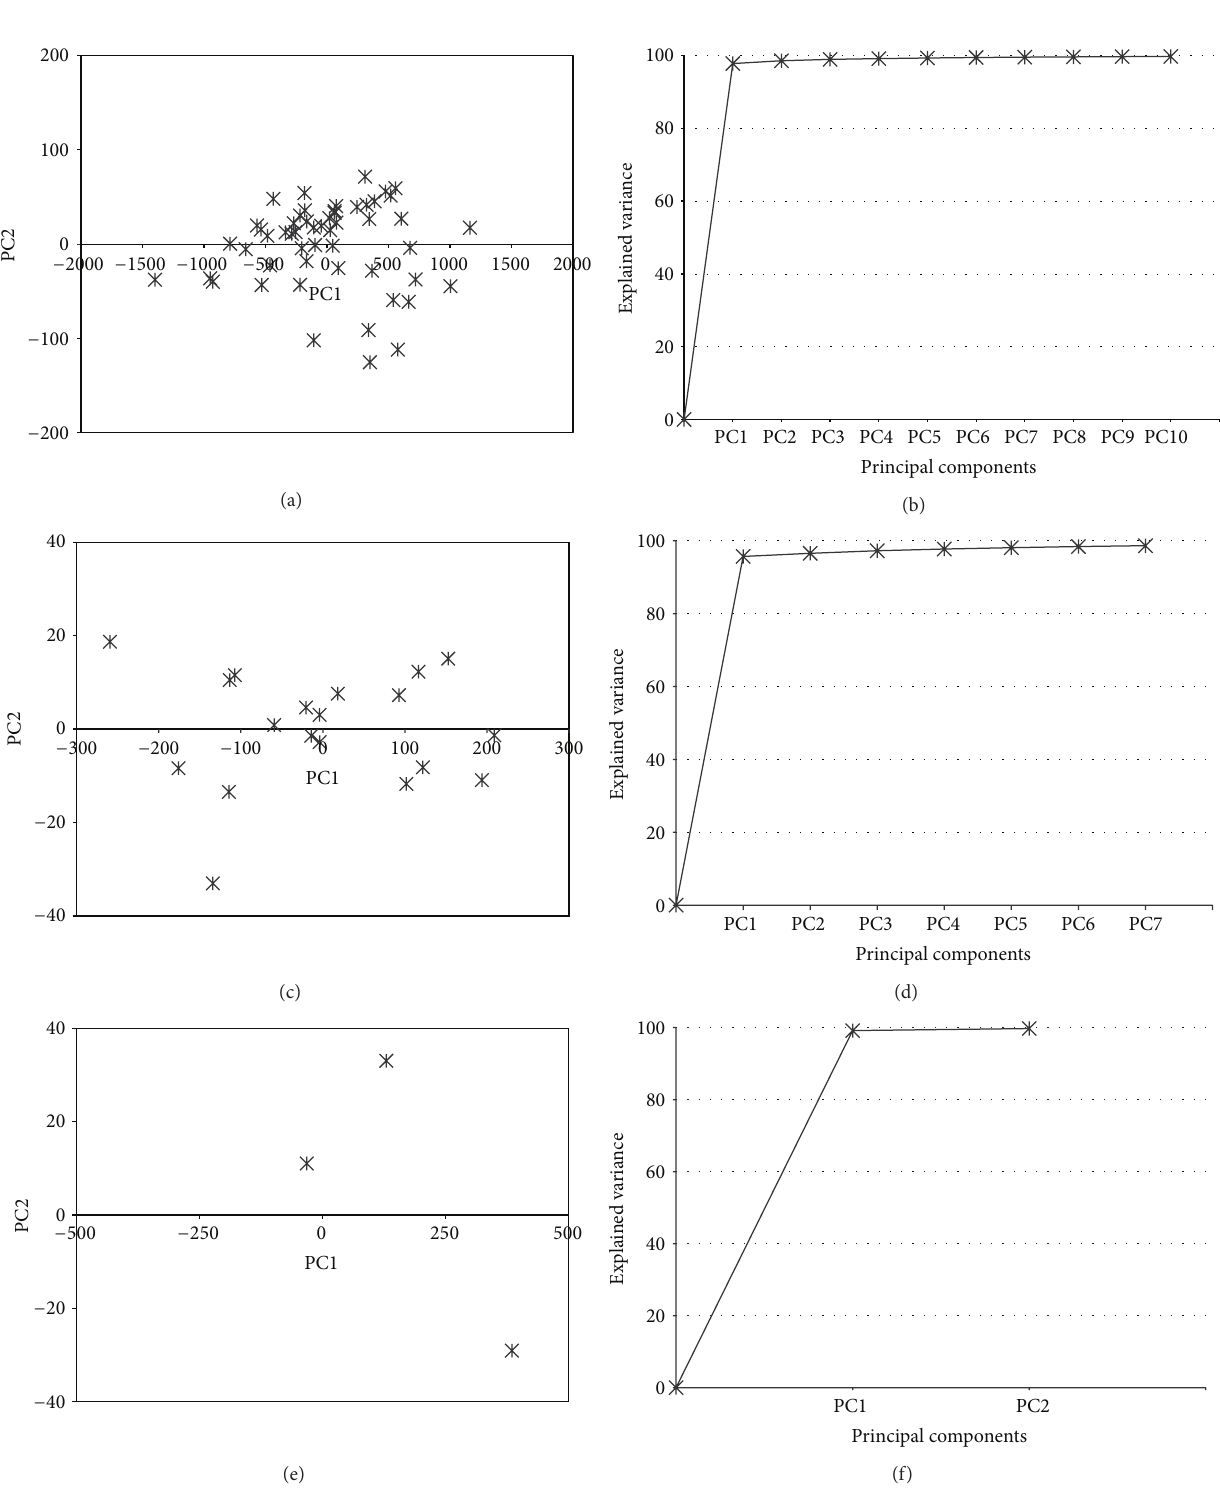
Figure 5: Results of PCA calculations ((a) and (c)) scores for the first and second principal components; ((b) and (d)) variance as a function of principal components for all thermal fingerprints for French and UK routes and for only 4 thermal fingerprints ((e) and (f)) for the UK